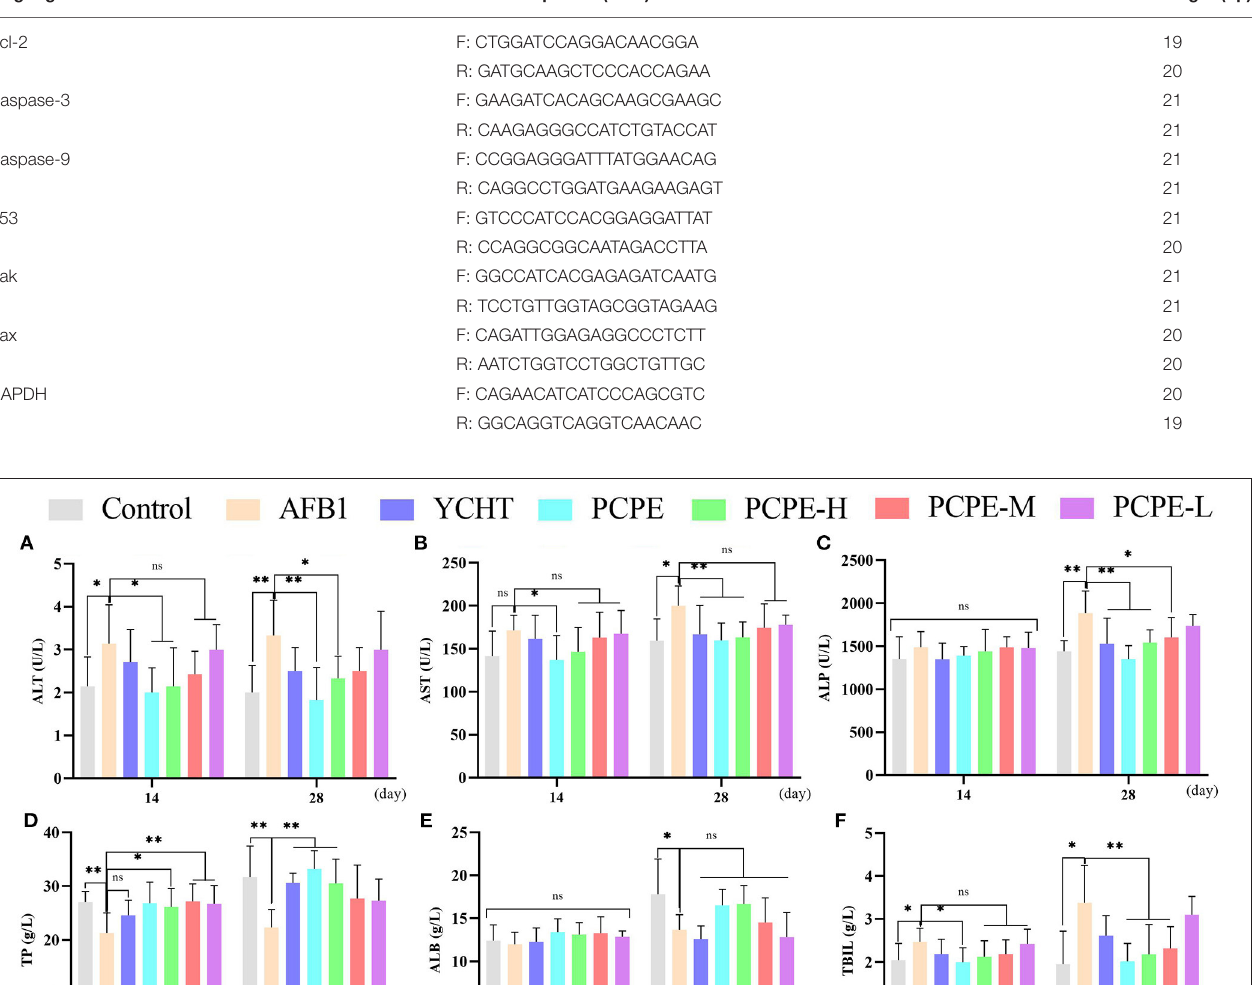
TABLE 1 | Primers for quantitative real-time PCR (19). Target gene